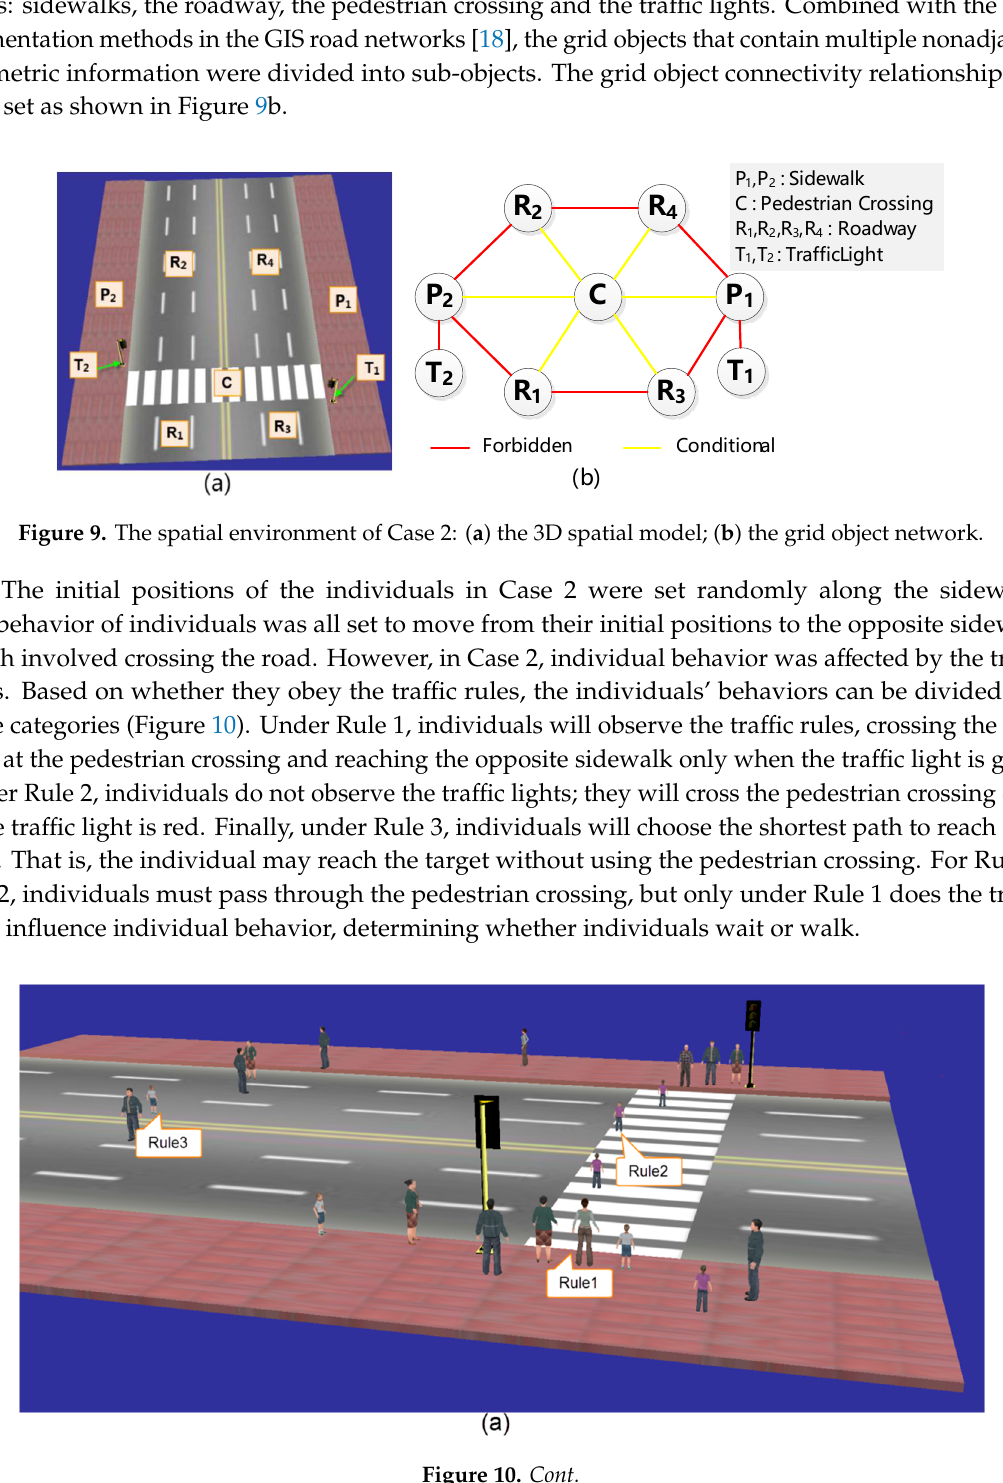
Figure 8. The 3D scene of individual behavior simulation in an emergency. The upper middle area shows the region of emergency diffusion.